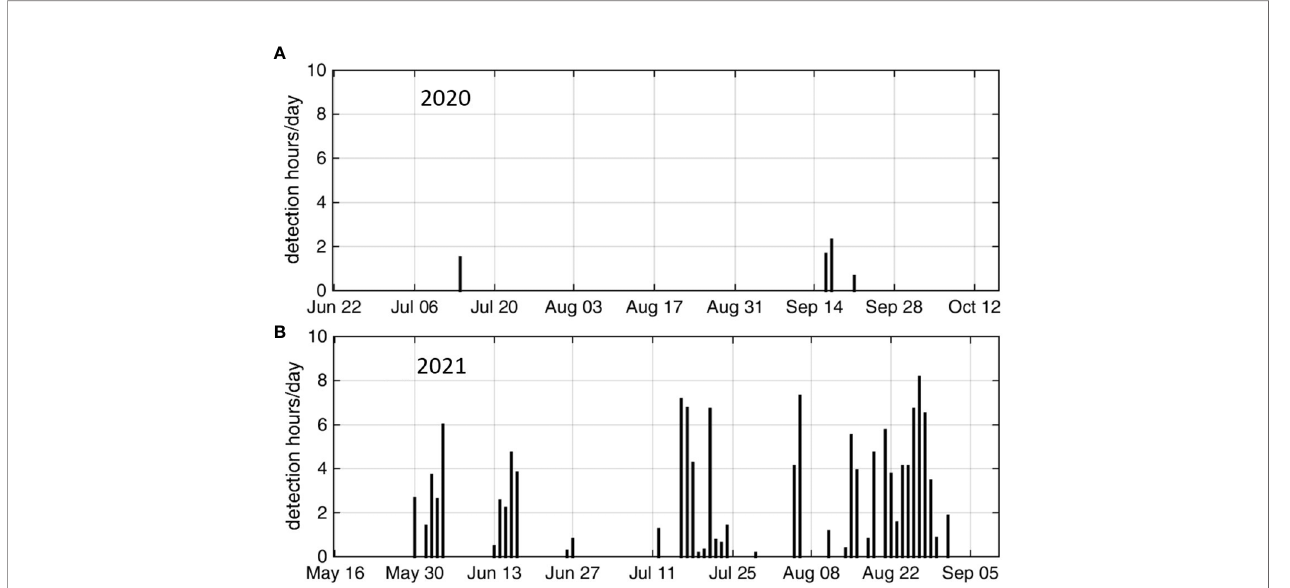
FIGURE 4 | Daily sperm-whale detections during the deployments (A) in 2020 and (B) in